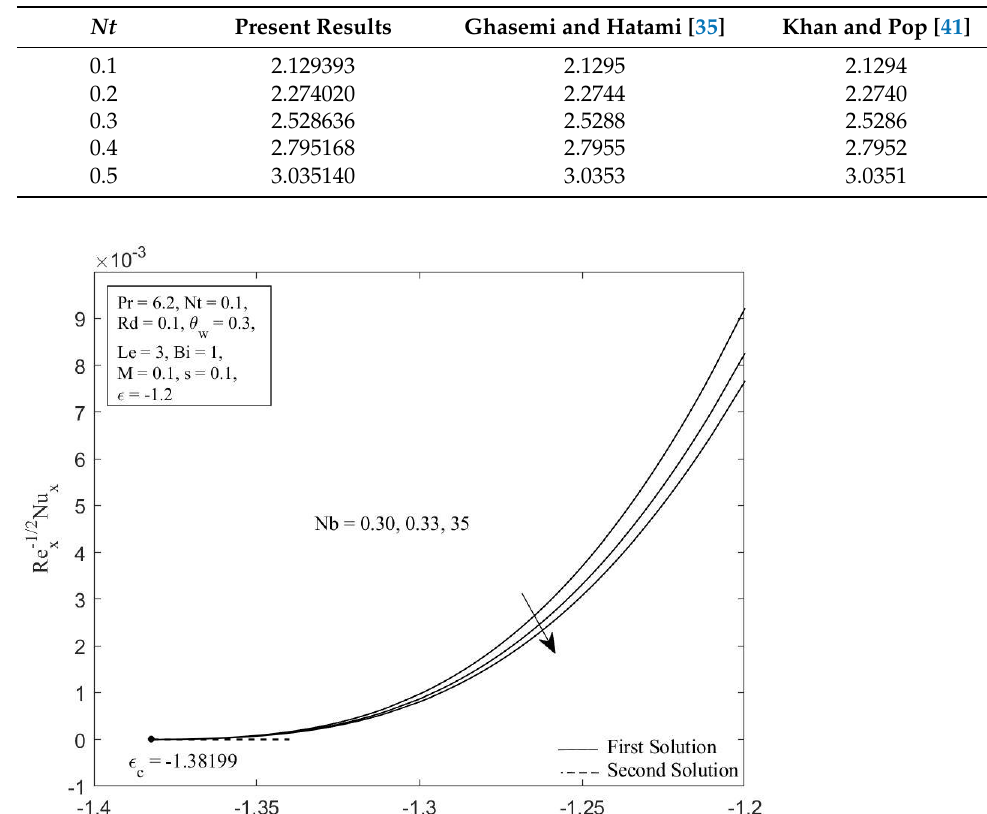
Table 2. Comparison data for the values of Sh x Re − 1/2 x for various values of Nt when Pr = Le = 10, Nt = 0.1, and Rd = 0.